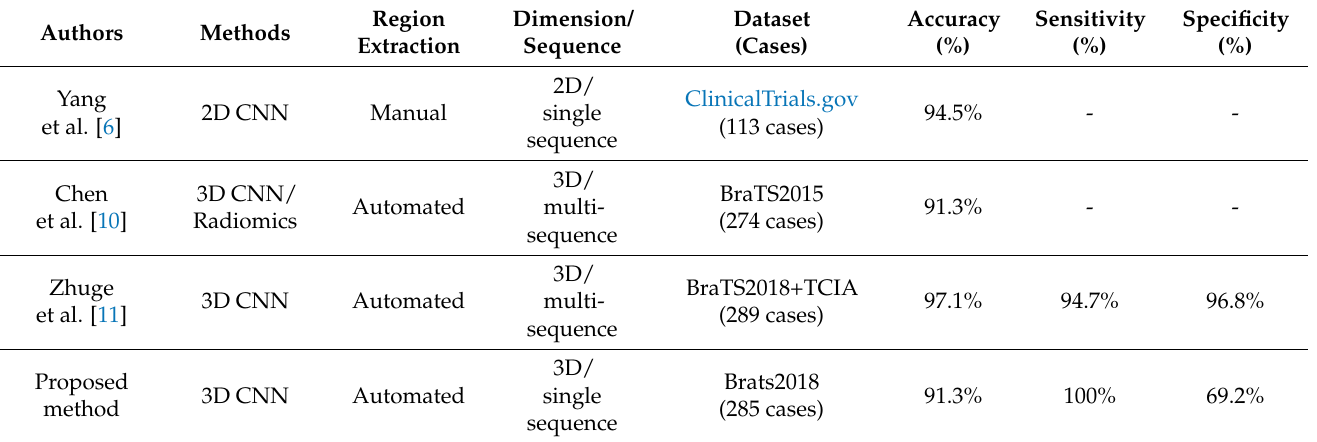
Table 3. Comparison of the proposed approach with other